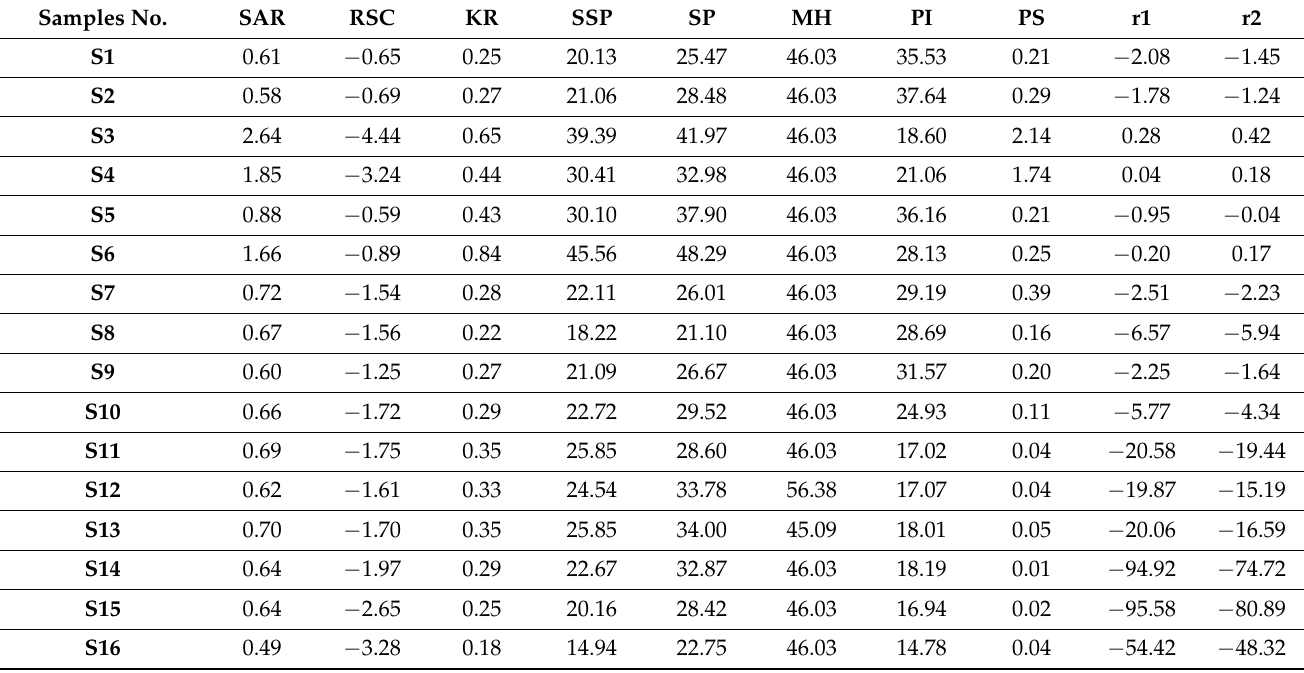
Table 4. Irrigation water quality indices results for the different spring and well water samples investigated in the present